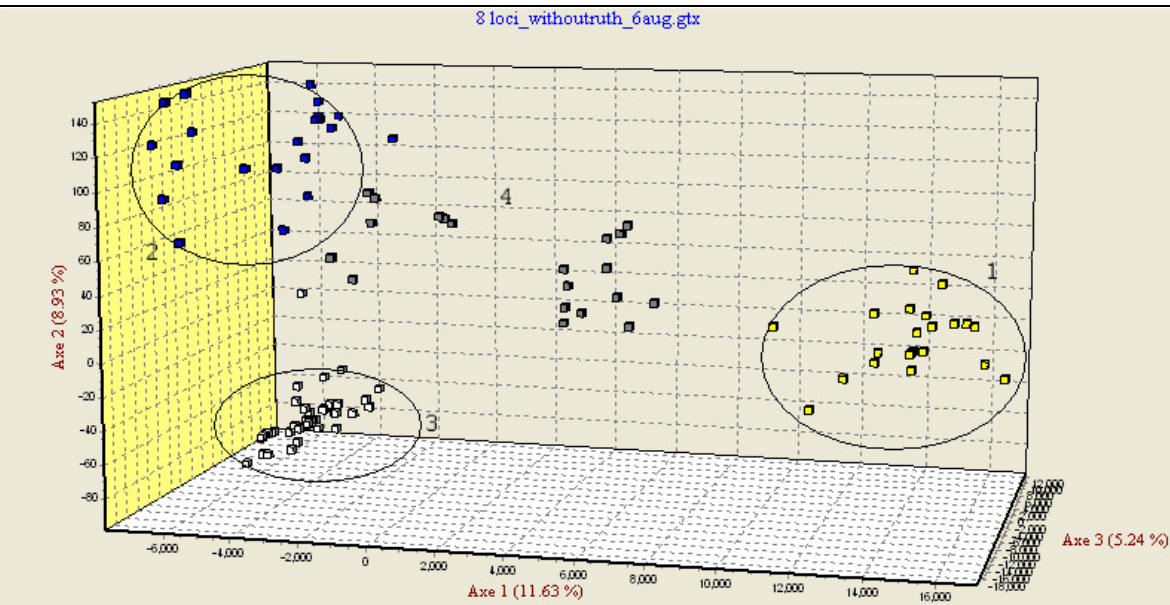
Figure 1. Factorial Correspondence Analysis (FCA) based on eight microsatellite loci in three pure species and hybrids of Danube sturgeons: (1) A. stellatus ; (2) H. huso ; (3) A. gueldenstaedtii ; (4) Hybrids and some pure